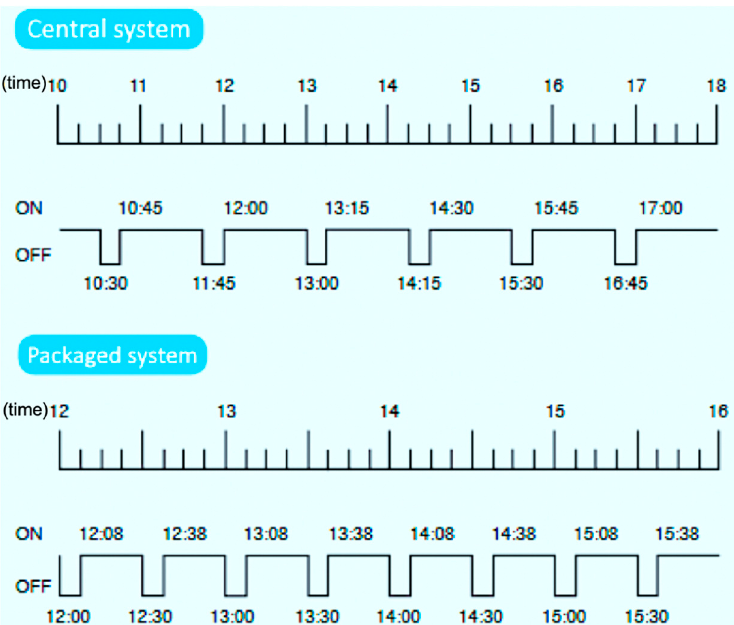
Figure 3. The intermittent control scheme of TPC for central systems and packaged systems (trans- lated)